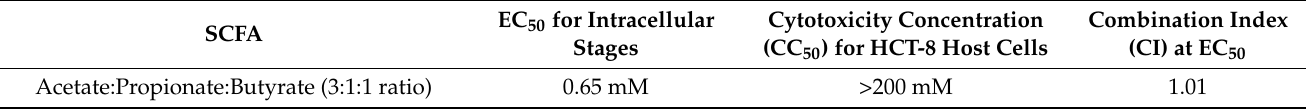
Table 2. Effects of combination of short-chain fatty acids on infected HTC-8 cells. EC 50 and CC 50 of HCT-8 cells infected and treated with a combination of acetate, propionate and